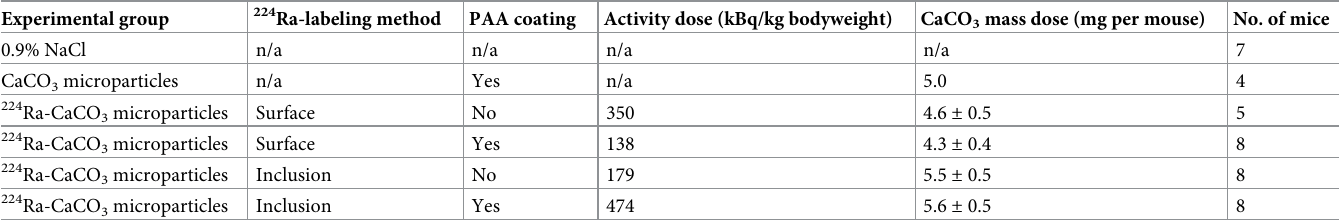
Table 2. Overview of the experimental groups included in the study investigating the therapeutic efficacy of 224 Ra-CaCO 3 microparticles in mice. Experimental